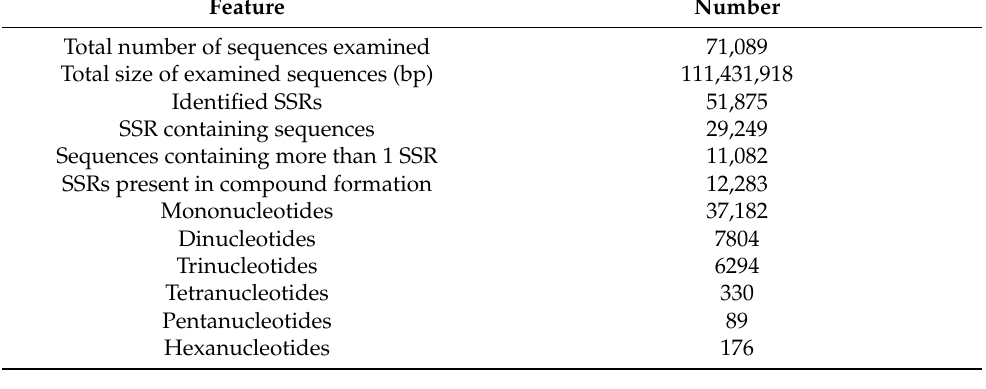
Table 3. Results of SSR analysis.